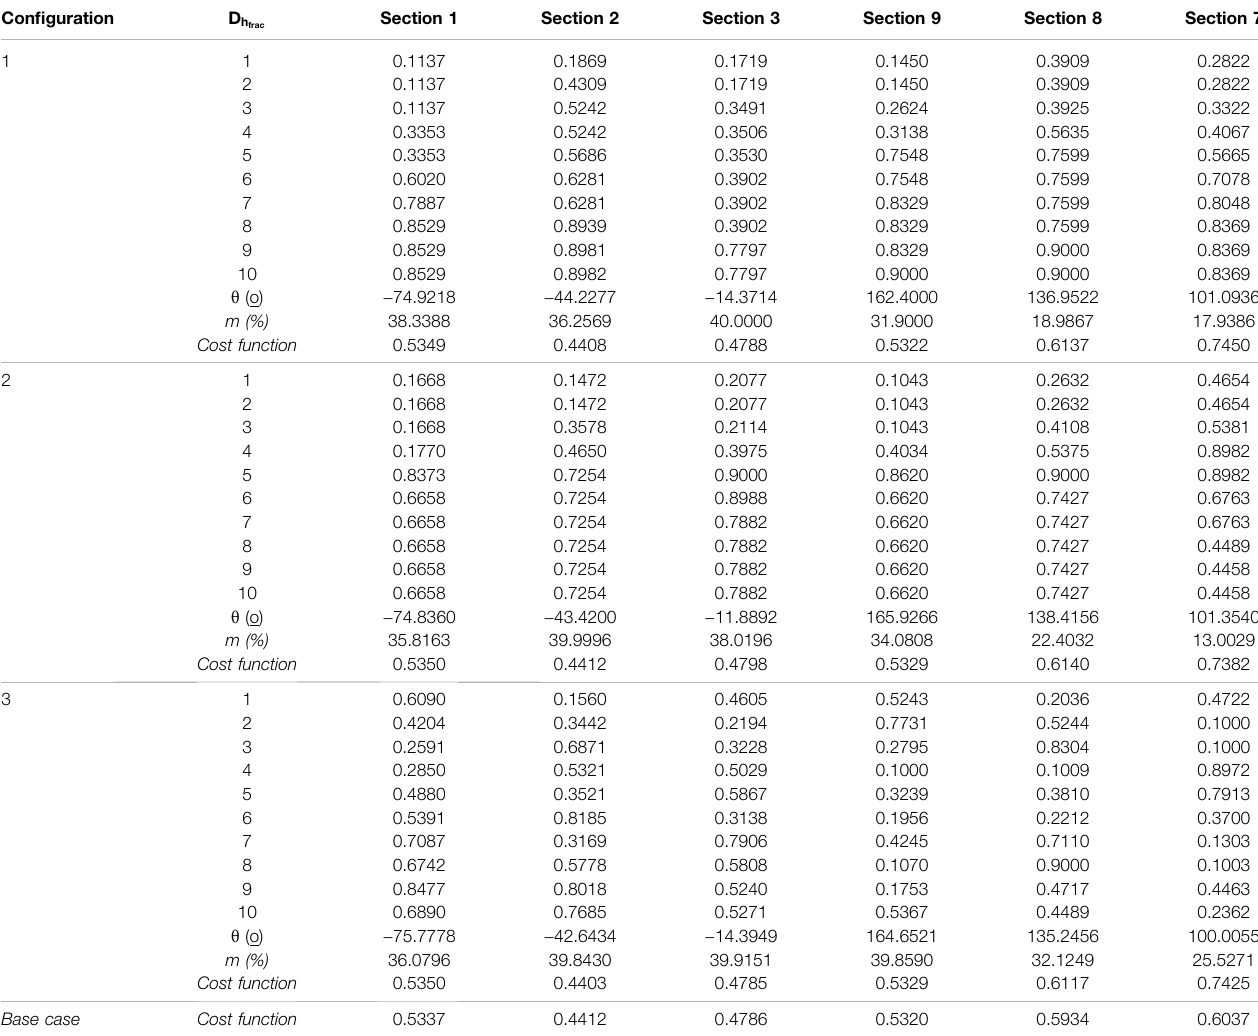
TABLE 3 | Results from the optimization procedure for each con fi guration. Con fi guration D h